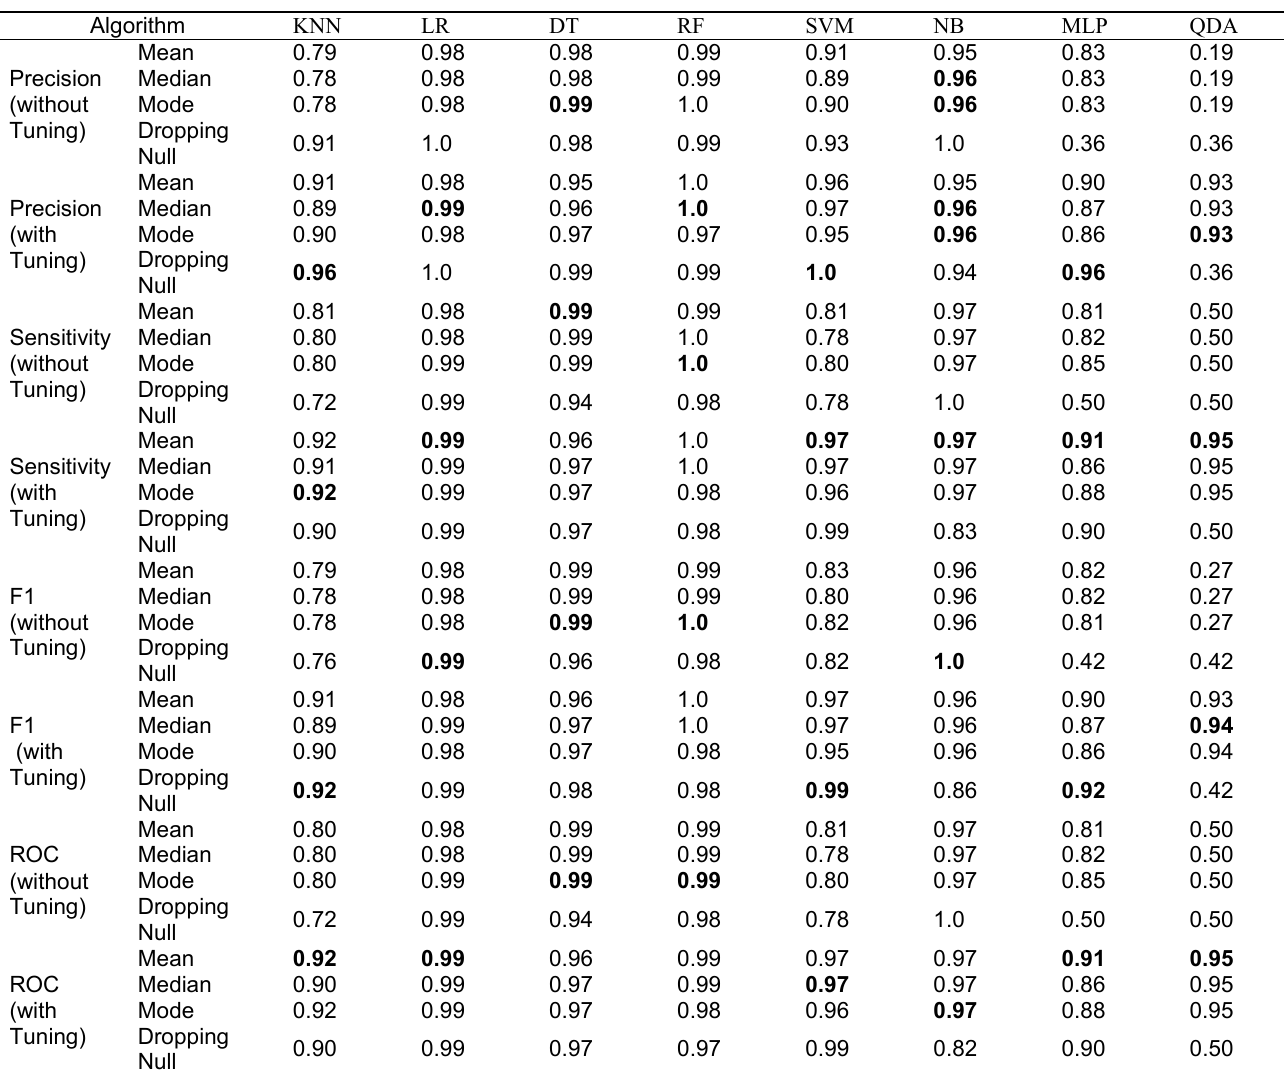
Table 11. Performance Parameters of different ML